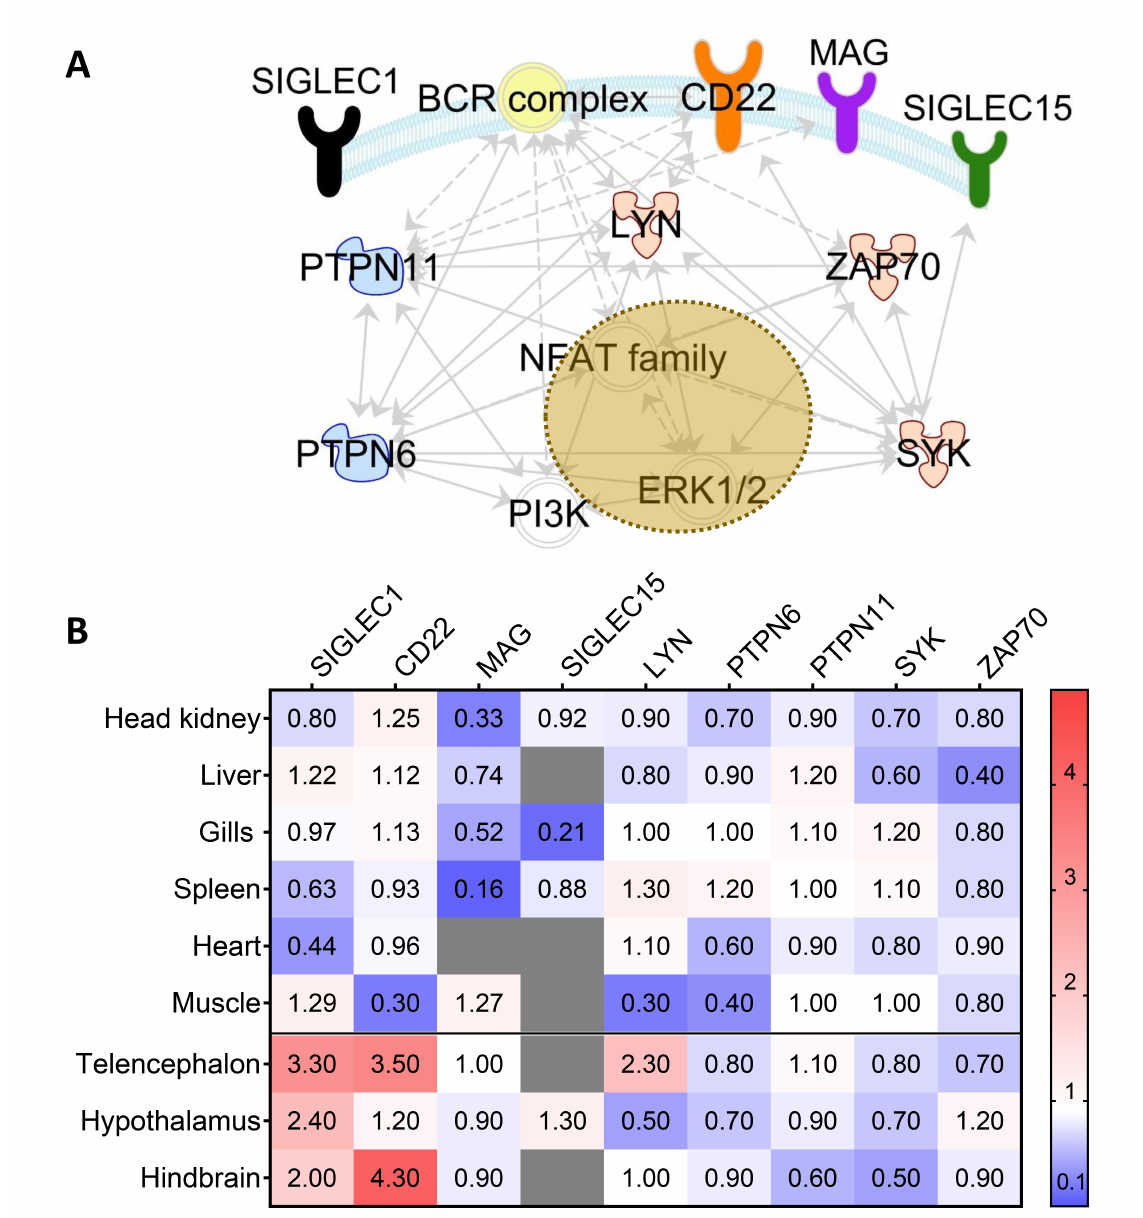
Figure 7. ( A ) Functional relationship between Siglec receptors and associated kinases (red symbols) and phosphatases (blue symbols) in a schematic B cell. Interactions are displayed by broken (indirect influence) or full (direct influence) lines. Cellular and nuclear membranes are colored in light blue and brown, respectively. Please note that these relationships are supported by at least one reference, which are based exclusively on investigations in mammalian species (accessible in the Ingenuity Knowledge Base). ( B ) Tissue-specific expression of genes encoding Siglecs ( Siglec1 , CD22 , MAG , Siglec15 ) and downstream factors ( LYN , PTPN6 , PTPN11 , SYK , ZAP70 ) in maraena whitefish exposed to three hours of handling stress. QPCR data were normalized by the reference genes RPL9 , EEF1A1b , and RPL32 . The heat map shows the averaged fold-change values in the respective tissue relative to the same tissue from unstressed fish, colored according to the code on the right. Non-detectable transcript numbers are indicated by gray